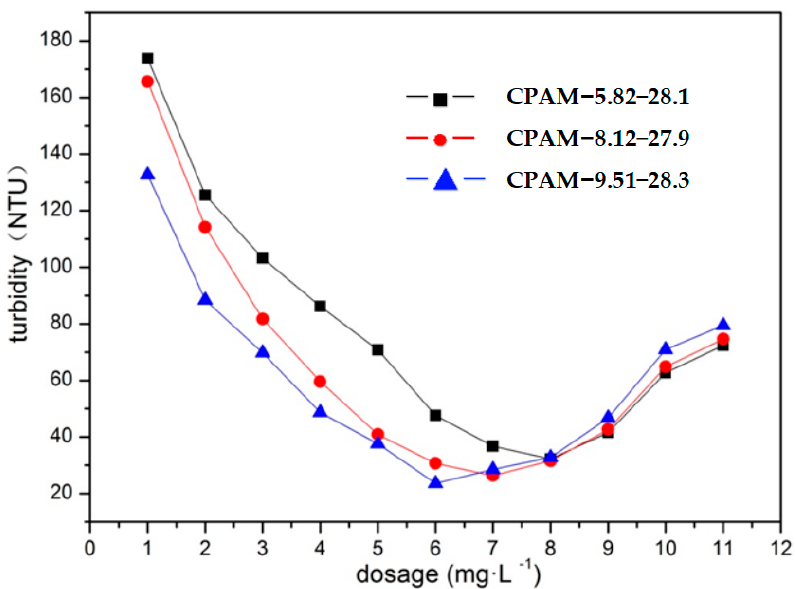
Figure 3. Impact of the dosage and intrinsic viscosity of CPAM on its flocculation effect.